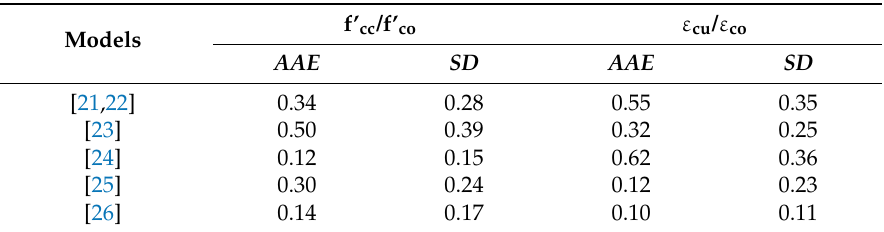
Figure 6. Ultimate axial strain predictions of investigated models. Table 6. Statistics for models.